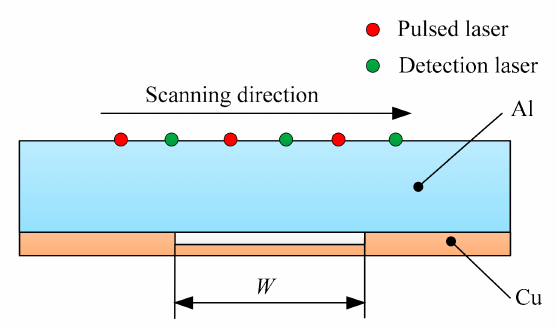
Figure 9. The schematic of scanning laser source method.